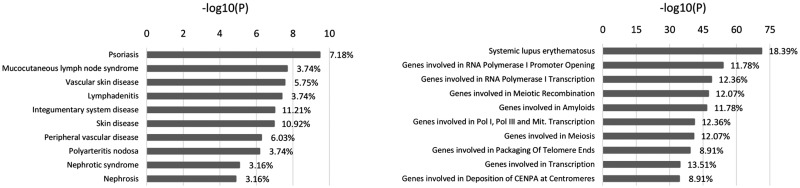
Enrichment analysis on regions with large deviations for any ancestry. Top ten significantly enriched human diseases (left) and MSigDB pathways (right).